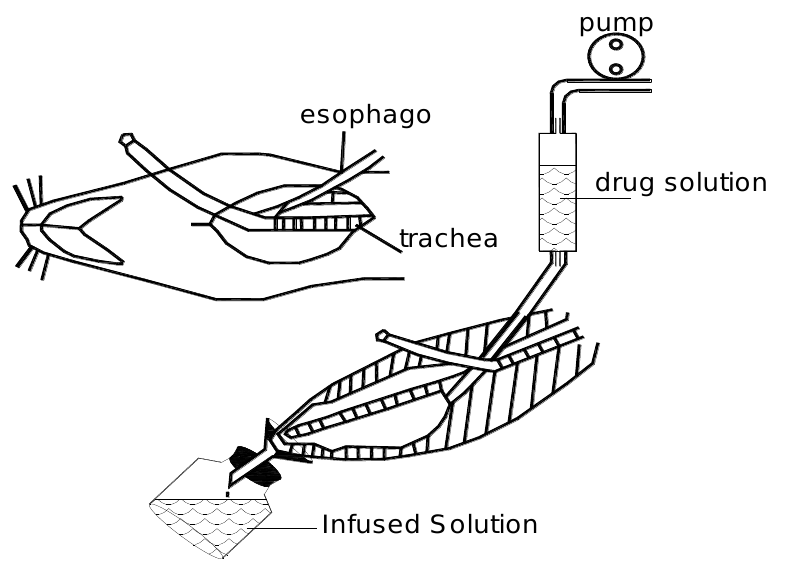
Figure 2. Diagram of in situ nasal single pass